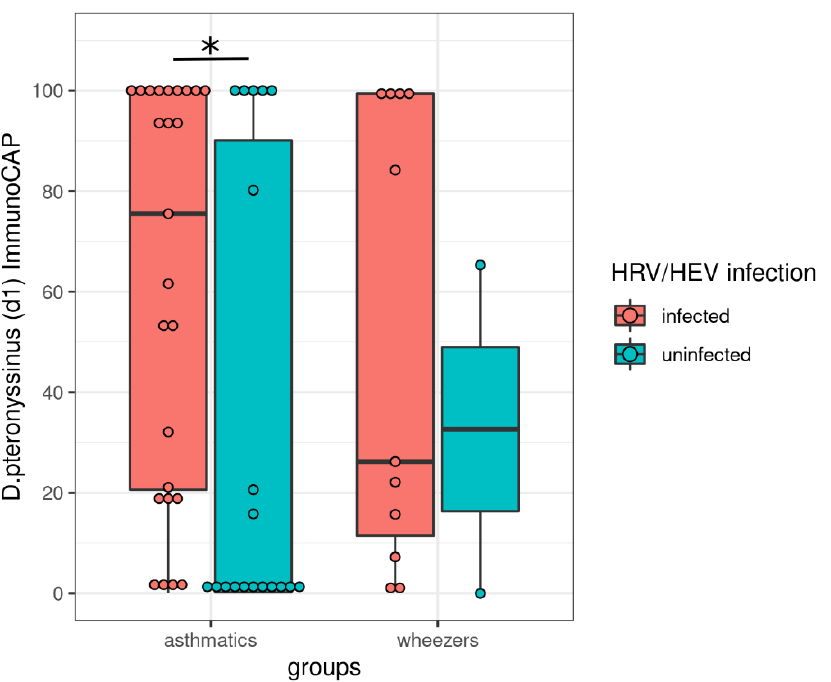
Figure 4. Patients with house dust mite allergies are susceptible for rhinovirus infection. We hypothesized that dust mite allergy levels, as measured by ImmunoCAP, influence the susceptibility to viral infections. We restricted our analysis to HRV/HEV and RSV and to wheezers and asthmatics since too few healthy controls accepted to undertake ImmunoCAP. For each group and each virus, we conducted a Mann–Whitney U test to assess if the viral infection status correlated with dust mite allergy levels. We found that dust mite allergies increased in HRV/HEV infected asthmatics compared with non-infected asthmatics ( p = 0.031). * p < 0.05.